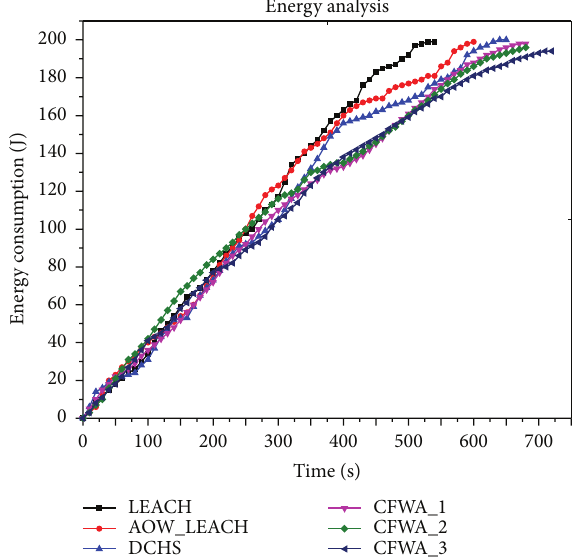
Figure 6: Energy analysis chart between CFWA family algorithms and LEACH-like algorithms in 100 nodes.